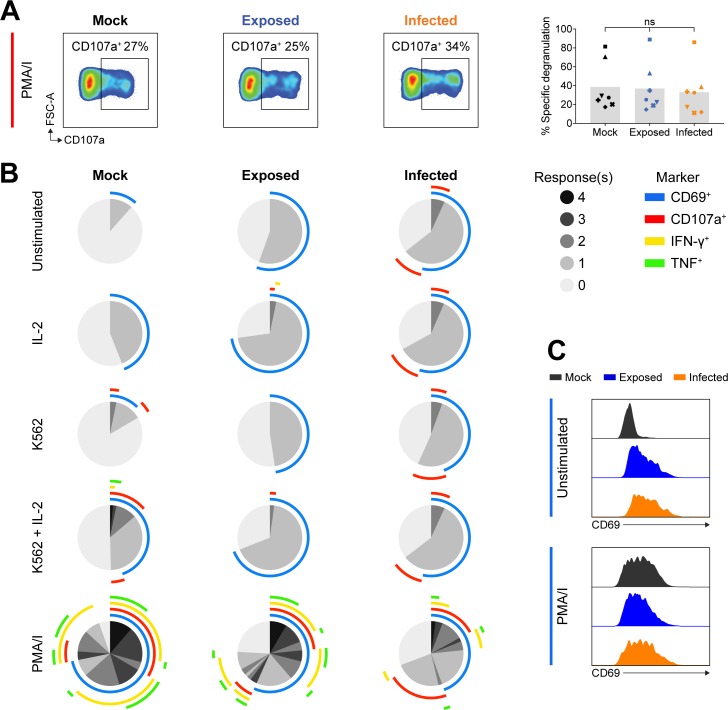
Polyfunctional analysis of VZV cultured NK cells.PBMCs were mock cultured, exposed to VZV, or VZV infected for 2 days and stimulated as specified for flow cytometry analysis of NK cells (viable CD3–CD56+ cells). (A) Degranulation (CD107a+) following stimulation with PMA and ionomycin (PMA/I). Graph shows specific degranulation with PMA/I stimulation for seven donors. Symbols represent individual donors, and grey columns indicate mean. ns = not significant (Friedman test with Dunn’s correction). (B) SPICE pie charts show the proportion of responses to different stimuli (listed left) based on combinations of detected CD69, CD107a, IFN-γ and TNF expression. Pie slices indicate the number of responses (0–4) (key, middle right). Arcs detail which markers were detected for each response (key, outer right). Data represent the means of three donors. (C) Histograms show CD69 expression for NK cells either unstimulated (above) or stimulated with PMA/I (below), for one representative donor (n = 6 donors).